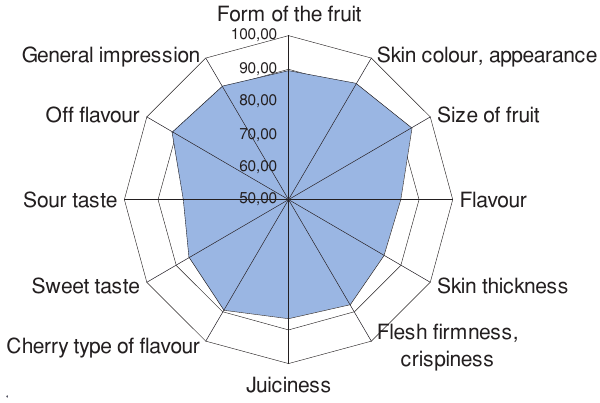
Figure 14. Profile diagram of the sensorial judgement of the variety